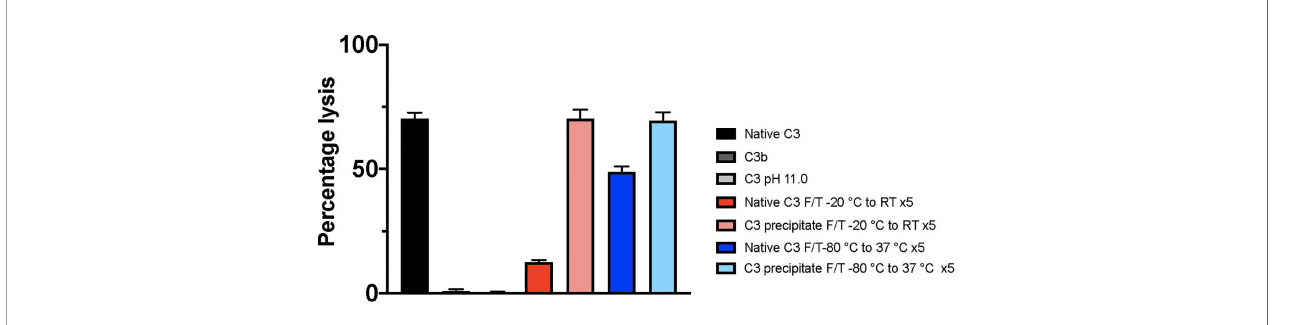
FIGURE 2 | Hemolytic activity of different C3 preparations (identi fi ed by the panel designations in Figure 1 and Table 1 ) analyzed by a hemolytic assay of the classical pathway. The lysis of 0.05% IgM sensitized erythrocytes, i.e., the hemolytic activity of C3, was determined by adding the cells into C3-depleted serum spiked with 0.4 µg/mL of native C3 (A), C3b, pH 11- treated C3 (L) or different preparations of F/T C3; precipitated and native C3 subjected to fi ve F/T cycles from -20°C to RT (D, F) and C3 subjected to fi ve F/T cycles from -80°C to 37°C (I, G), respectively. Total lysis was obtained by lysing the cells in pure water. The absorbance was measured at 414 nm. All samples were run in quadruplicates (n = 4). F/T, freeze/thaw; RT,